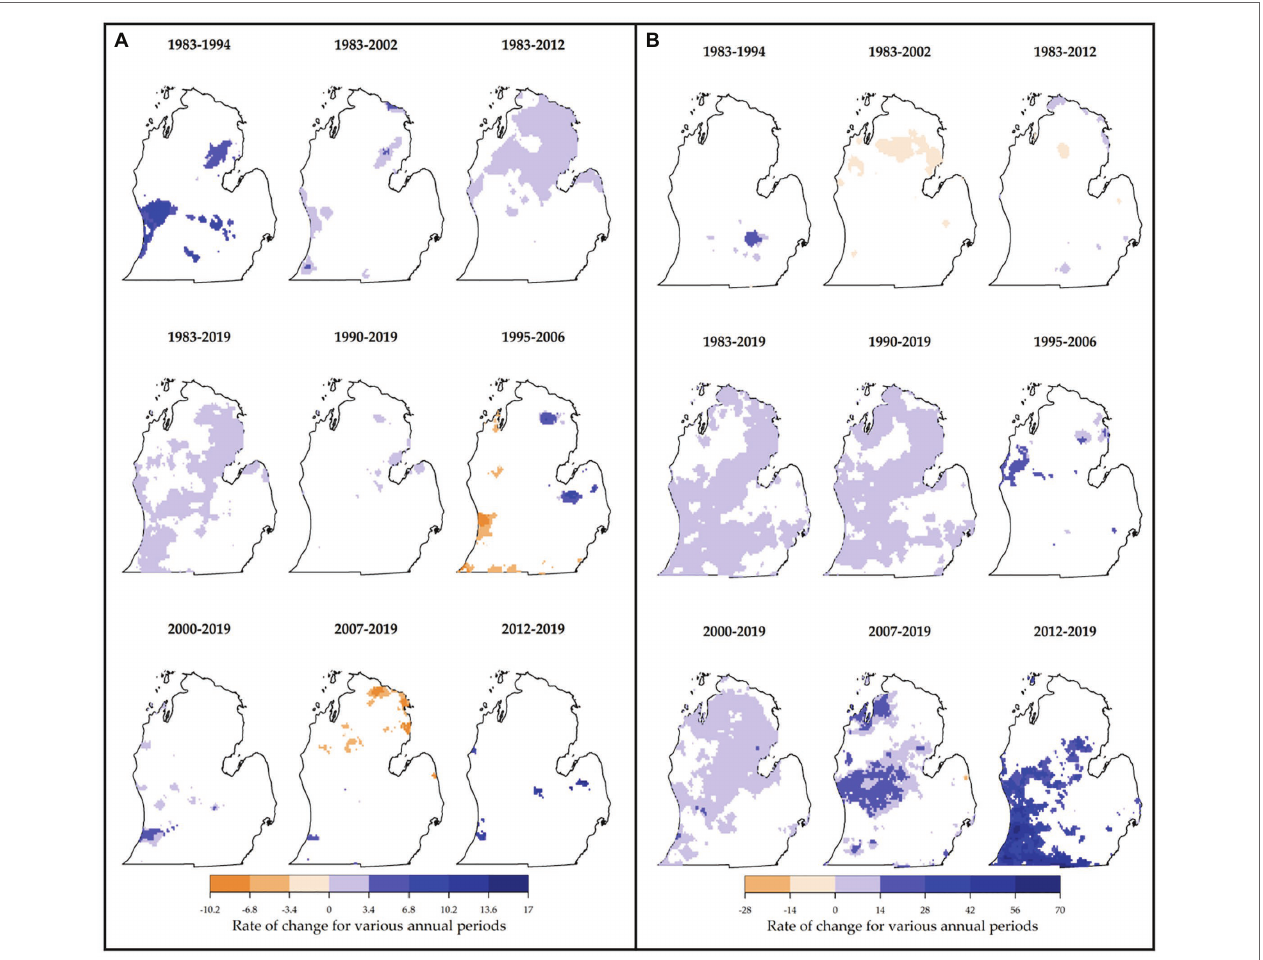
FIGURE 7 | Locations of persistently changed precipitation (mm per year) are shown for key growth periods (A) and the general growing season (B) . Highest proportions of changed area during key growth periods were found in 1983–2019 and 1983–2012. Greatest changes in the variable were observed mainly in 1983–1994 (+ change). For reference, precipitation during critical growth periods ranges from 0 to 360 mm ( Table 1 ). During the general growing season, negative changes in precipitation were mostly observed in 1983–2002 and 1983–2012. Total growing season precipitation typically ranges from 245 to 1,000+ mm per year ( Table 1